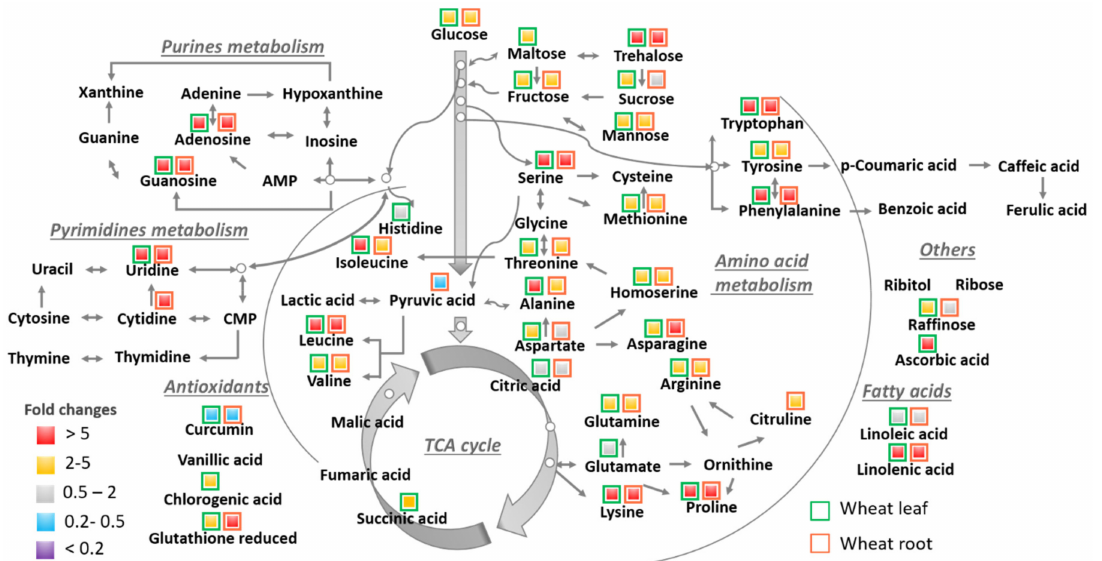
Figure 2. Significant metabolic pathway changes in wheat after one-week foliar exposure to surfactant solution. The color scale indicates the fold changes compared with DI water. The border of the box indicates whether the metabolite changes happened in wheat leaves (green) or roots